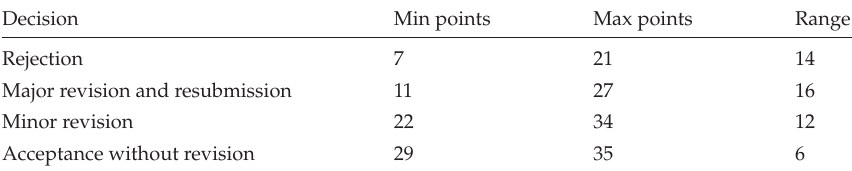
Table 20: Overlapping points and decisions for